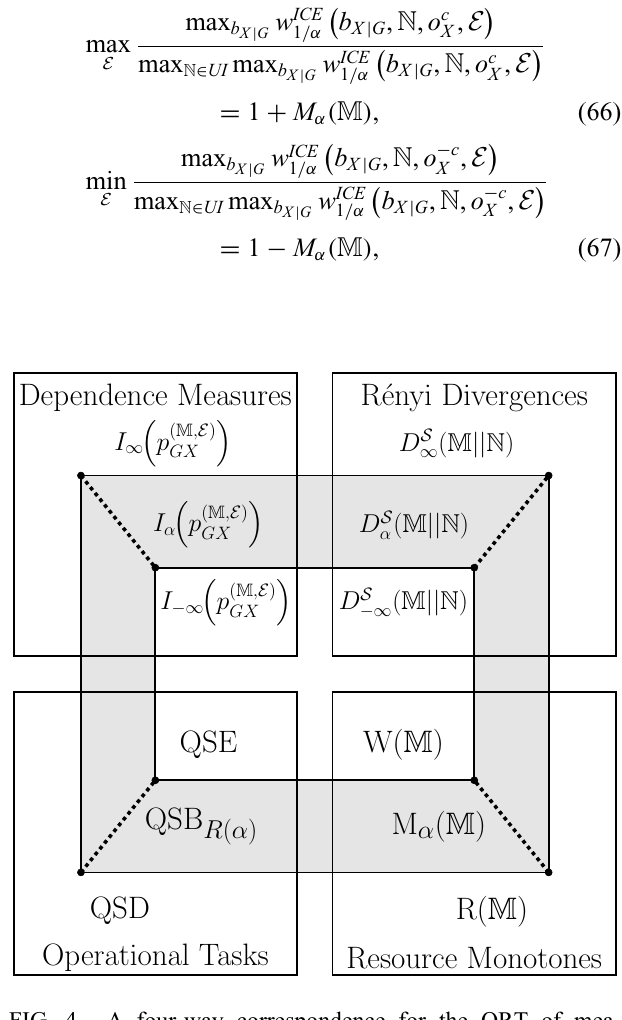
FIG. 4. A four-way correspondence for the QRT of mea- surement informativeness. The correspondence is parametrized by the Rényi parameter α ∈ R ∪ {∞ , −∞} . The outer rect- angle represents α = ∞ , the inner rectangle represents α = −∞ , and the shaded region in between represents the values α ∈ R . This four-way correspondence links operational tasks, dependence measures, Rényi divergences, and resource mono- tones. The operational task is quantum state betting played by a gambler with risk aversion R (α) = 1 /α . This task general- izes quantum state discrimination (recovered when α → ∞ ), and M , E ) ) quantum state exclusion (recovered when α → −∞ ). I α ( p ( GX is Arimoto’s dependence measure, from which we recover the accessible information I acc ∞ ((cid:4) M ) when α → ∞ , and the excludible information I exc −∞ ((cid:4) M ) when α → −∞ , with (cid:4) M the measure-prepare channel of the measurement M . We introduce D S α ( M || N ) , the quantum Rényi divergence of two measurements M and N for a given set of states S = { ρ } . We also introduce x M α ( M ) , a new family of resource monotones, which generalize the robustness of informativeness R ( M ) (when α → ∞ ) and the weight of informativeness W ( M ) (when α → −∞ ). The outer rectangle was uncovered in Ref. [12], whilst the inner rectan- gle was first uncovered in Ref. [30]. The main set of results of this paper is to fill the shaded region, and connect these two correspondences for all α ∈ R